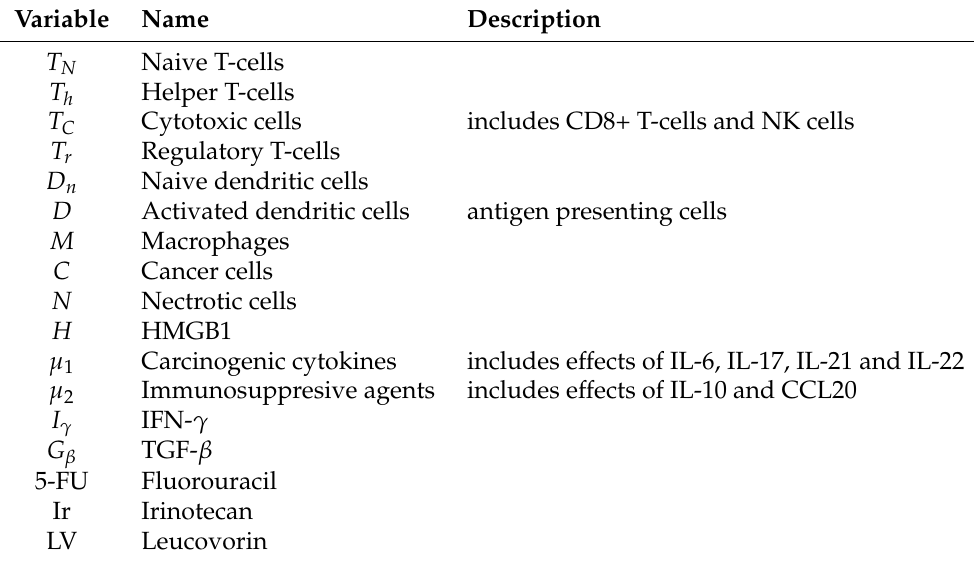
Table 1. Model’s Variables. Names and descriptions of variables used in the model.